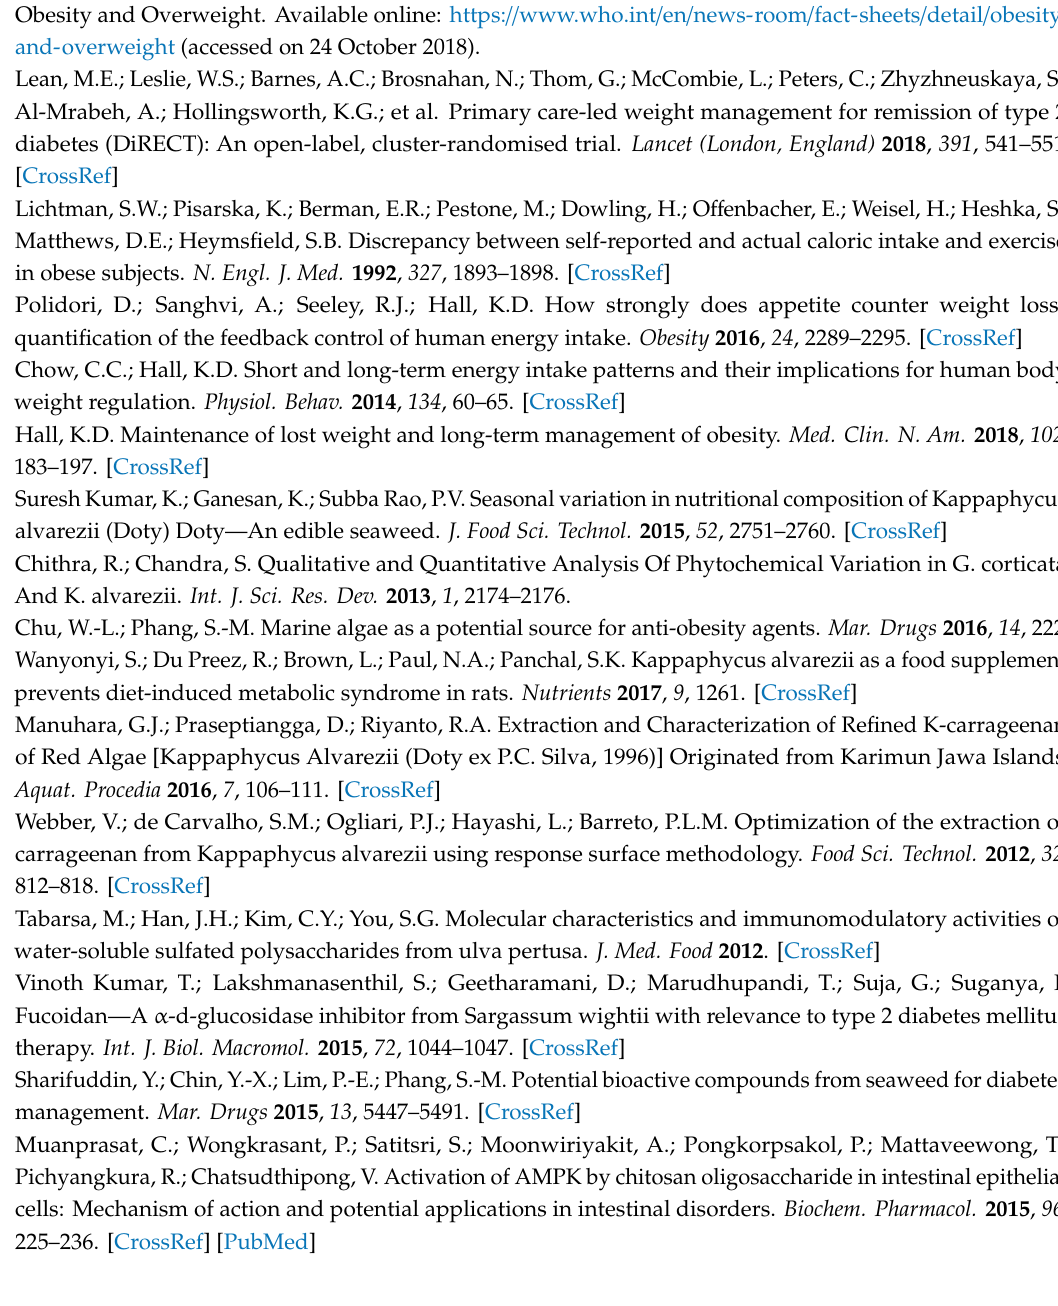
for D12451J (High-fat diet), Figure S1: Visceral fat of mice at the end of the experiment, Figure S2: Oil red staining of hepatic tissues, Figure S3: Scores for thymus and spleen indices, Figure S4: Hematoxylin and Eosin staining of colonic tissues, Figure S5: Lipid content in mice sera, Figure S6: Gut microbiota di ff erences in mice, Figure S7: The abundances of selected bacteria after